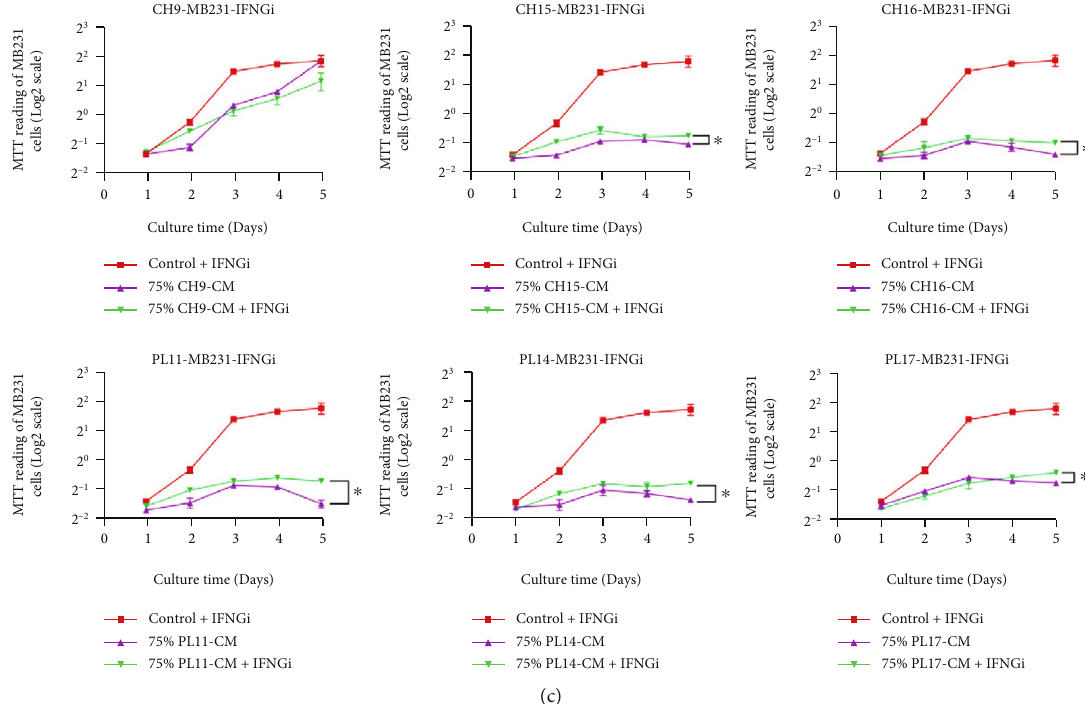
Figure 9: The e ff ect of DKK1, TGF- β , and IFN- γ on the proliferation of human breast cancer MDA-MB231 cells in the presence of soluble factors derived from PL-hMSCs and CH-hMSCs. (a) Graphs show the growth kinetics of MDA-MB231 cells cultured in 75% conditioned medium derived from CH-hMSCs and PL-hMSCs supplemented with the DKK1 antagonist CHIR99021 (75% CH-CM+CHIR and 75% PL- CM+CHIR, respectively) determined by the MTT assay. Data are presented as mean ± SEM of four experiments. MDA-MB231 cultured in DMEM medium +10% FBS supplemented with CHIR99021 (control+CHIR) served as controls. (b) Graphs show the growth kinetics of MDA-MB231 cells cultured in 75% conditioned media derived from CH-hMSCs and PL-hMSCs supplemented with TGF- β inhibitor SB431542 (75% CH-CM+SB and 75% PL-CM+SB, respectively) as determined by the MTT assay. Data are presented as mean ± SEM of four experiments. MDA-MB231 cultured in DMEM medium +10% FBS supplemented with SB431542 (control+SB) served as controls. (c) Graphs show the growth kinetics of MDA-MB231 cells cultured in 75% conditioned media derived from CH-hMSCs and PL-hMSCs supplemented with IFN- γ neutralizing antibody XMG1.2 (75% CH-CM+IFNGi and 75% PL-CM+IFNGi, respectively) determined by the MTT assay. Data are presented as mean ± SEM of four experiments. MDA-MB231 cultured in DMEM medium +10% FBS supplemented with XMG1.2 (control+IFNGi) served as controls. ∗ P < 0 : 05 between the compared groups. CH-CMs were prepared from 3 CH-hMSCs (CH9, CH15, and CH16), and PL-CMs were prepared from 3 PL-hMSCs (PL11, PL14, and